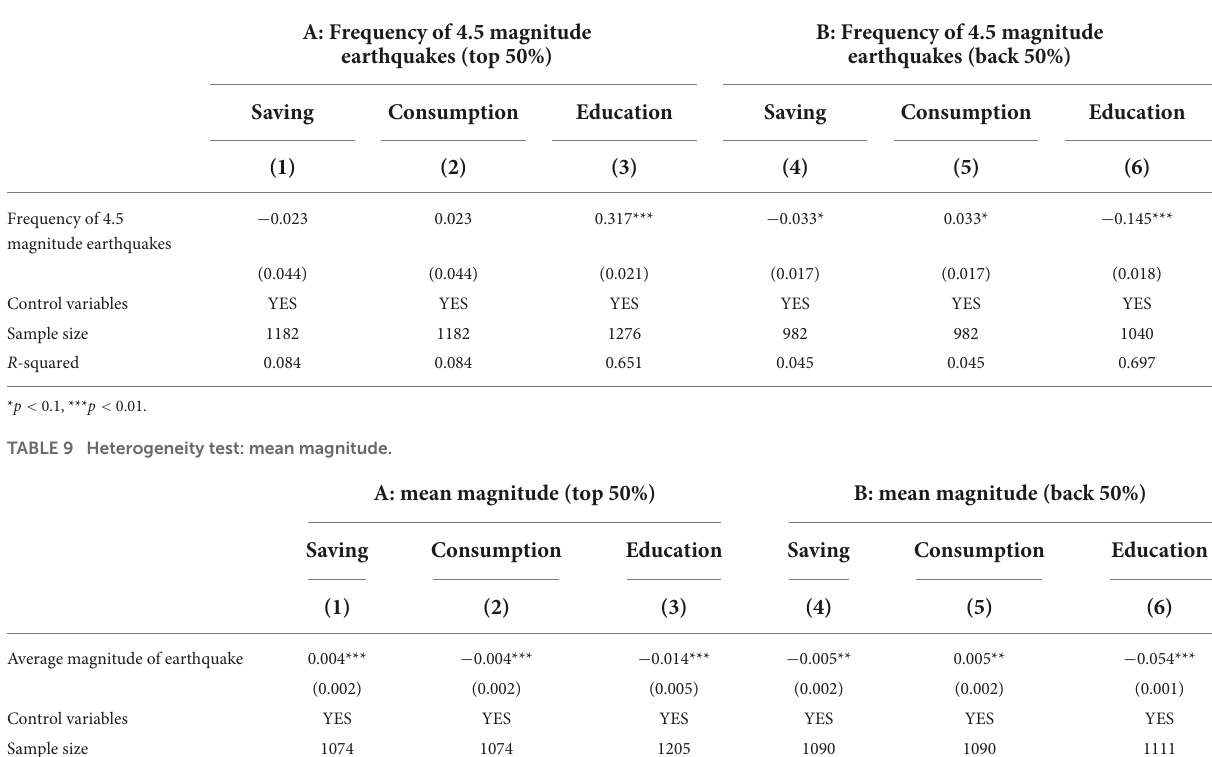
TABLE 8 Heterogeneity test: Number of earthquake occurrences.